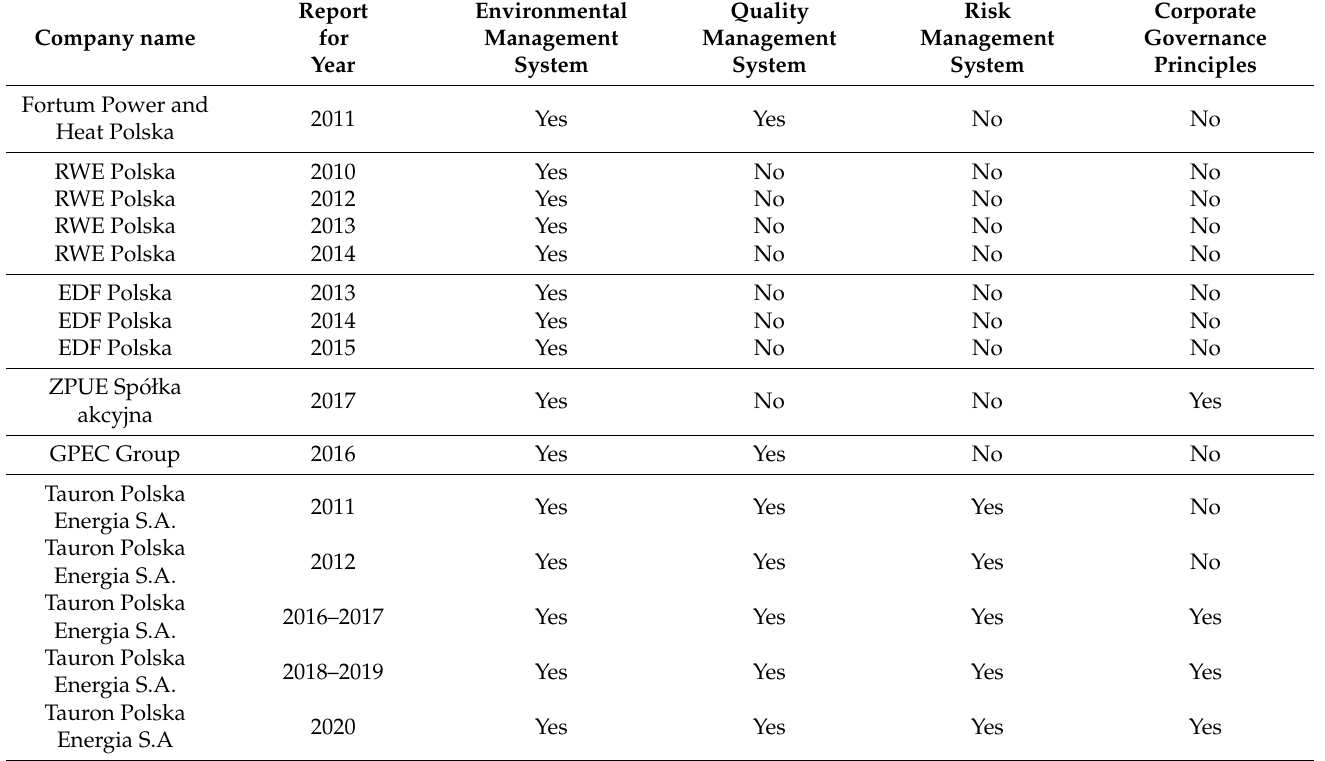
Table 4. The results of the preliminary overview of the energy companies’ reports in terms of disclosures on EMS, QMS, ERMS and